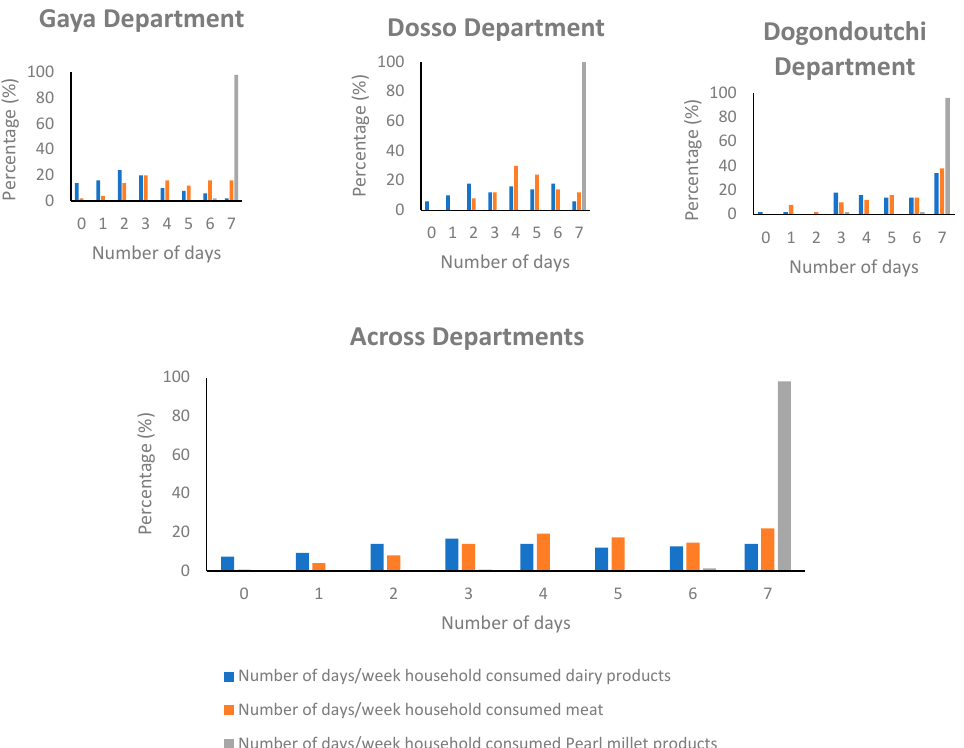
Figure 3. Household dietary diversity in three departments (Dogondoutchi, Dosso, and Gaya) of the Dosso region in Niger.